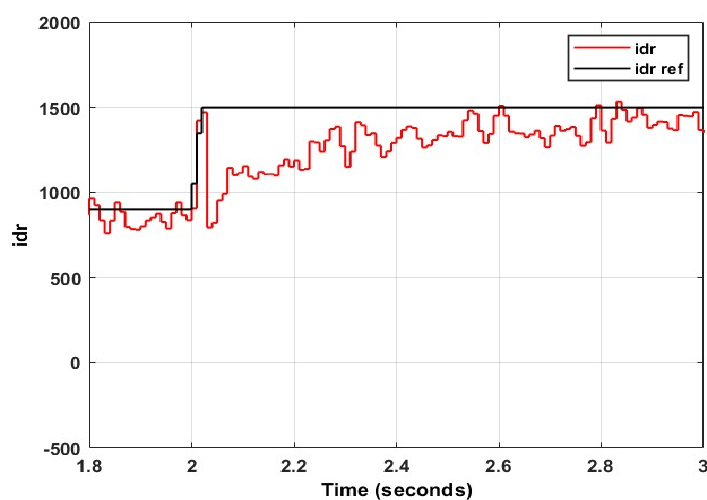
Figure 31. Rotor direct axis current ripple using LQR at 70% dip.